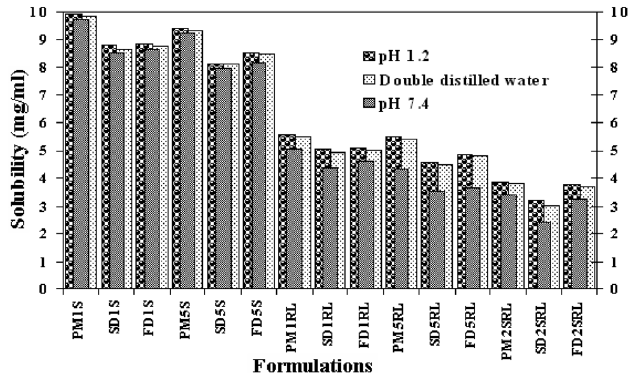
FIGURE 1 - Equilibrium solubility study of PHC and its solid dispersions in 0.1 N HCl (pH 1.2), Double distilled water, Phosphate buffer (pH 7.4)